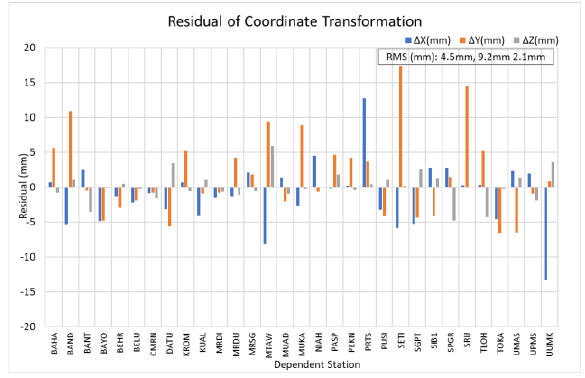
Figure 4 . Residual of Coordinate Transformation.